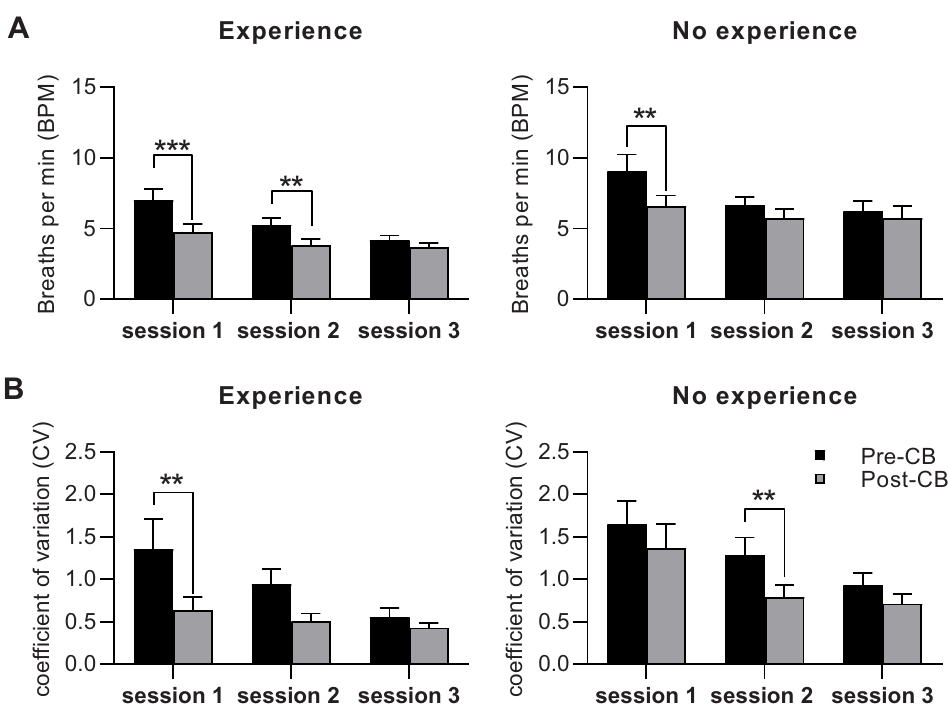
Fig 7. Objective respiratory measures improve irrespective of previous experience in controlled breathing. A) Average respiratory rate (breaths per minute) and B) respiratory rate variability (standard deviation of rate) collected before (pre-CB) and after training (post-CB) for each session, grouped based on participant-reported previous experience with controlled breathing. Post-hoc analysis (n = 15 per group; data presented as mean ± SEM; � p < 0.05, �� p < 0.01, ��� p < 0.001) CB = Controlled